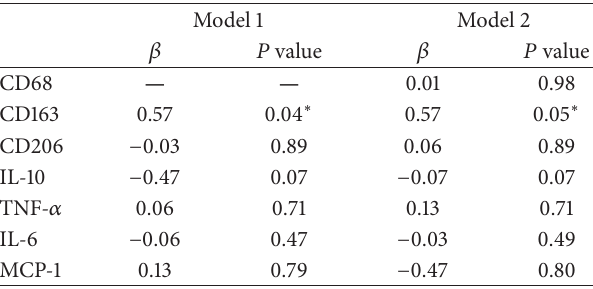
Table 4: Multivariate linear regression for HOMA-IR and M1- and M2-macrophage